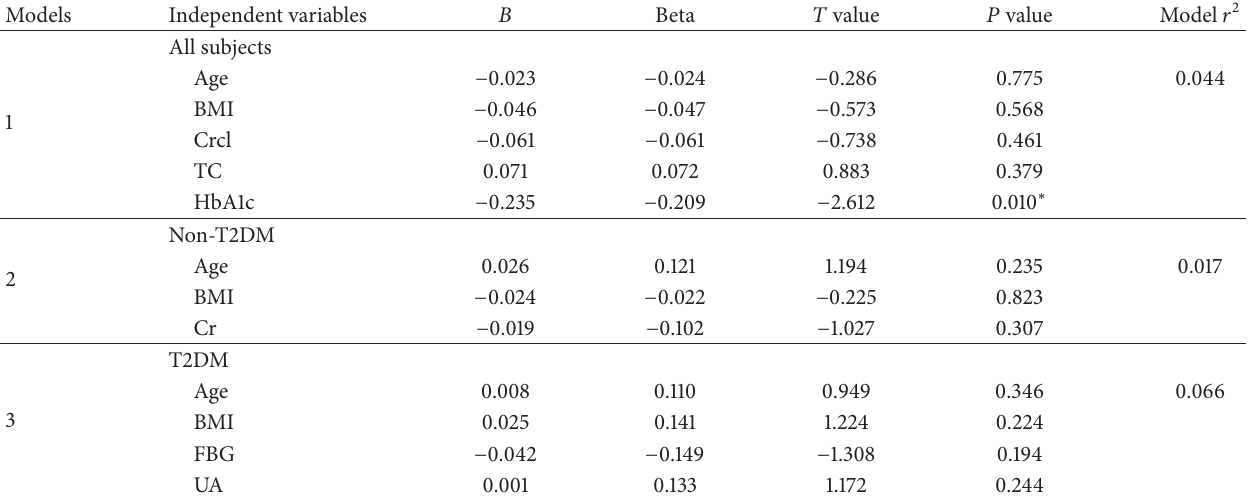
Table 5: Multivariate linear regression analyses of all subjects, patients with and without T2DM, using the serum vaspin levels as dependent